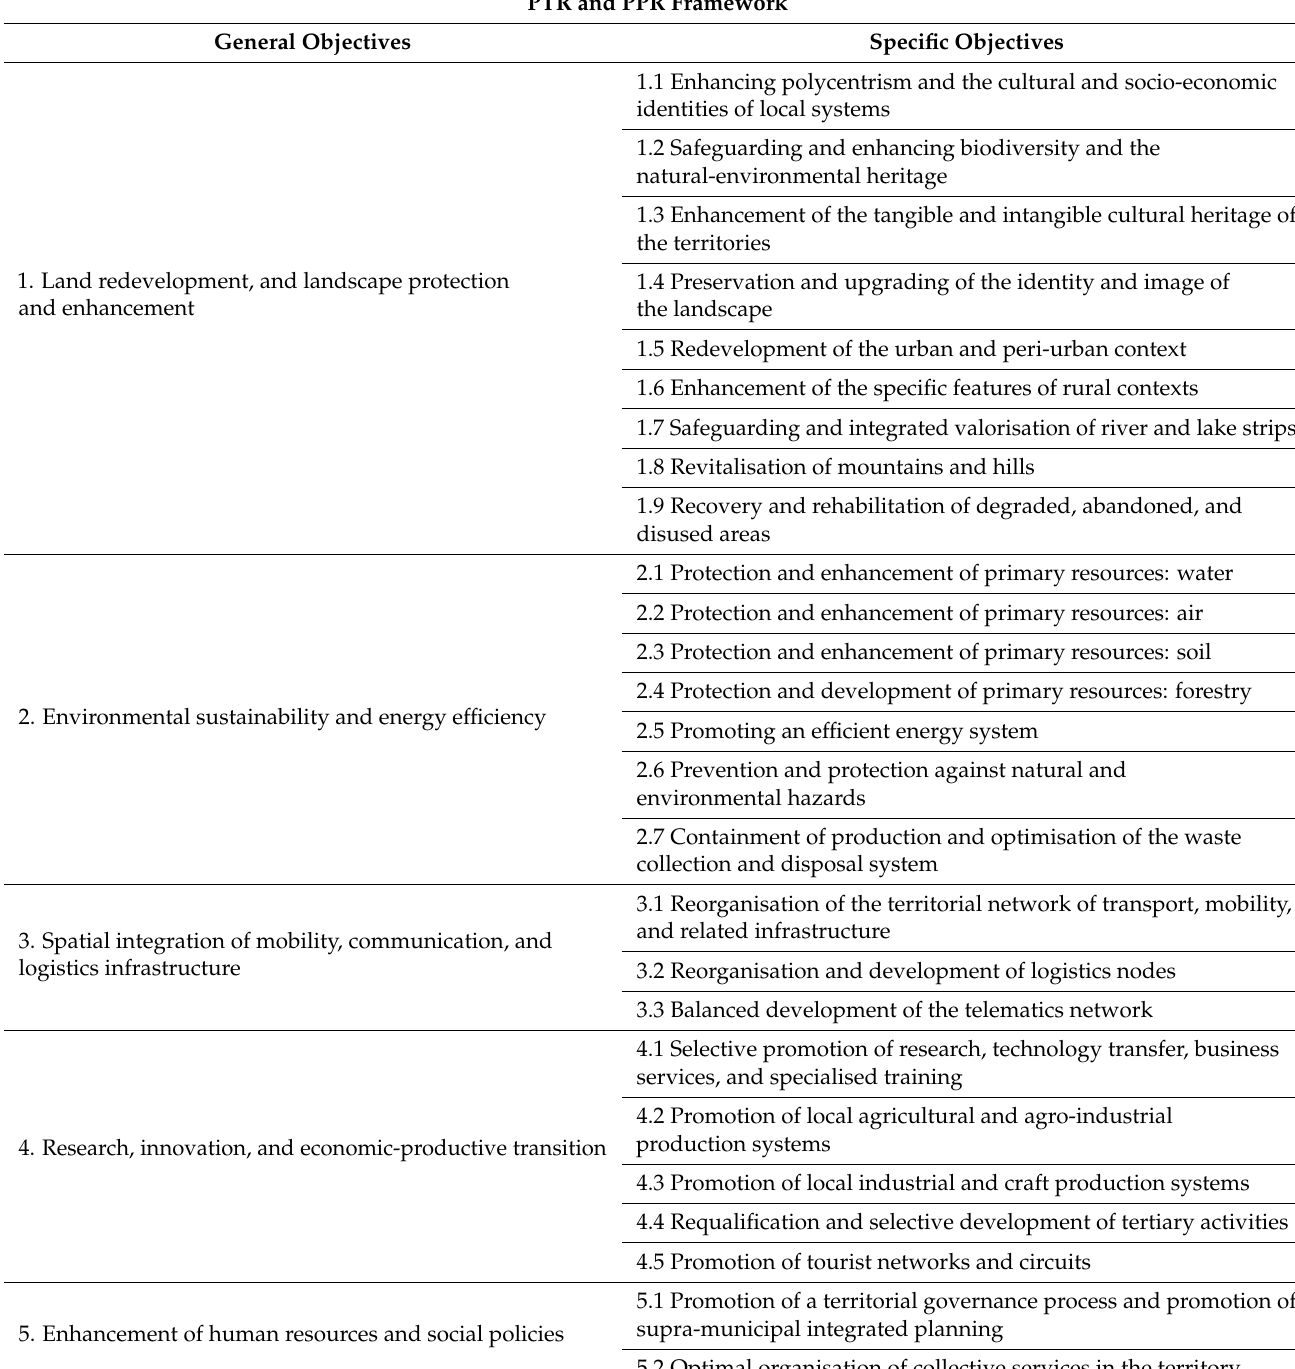
Table 12. Strategic framework of the PTR and PPR